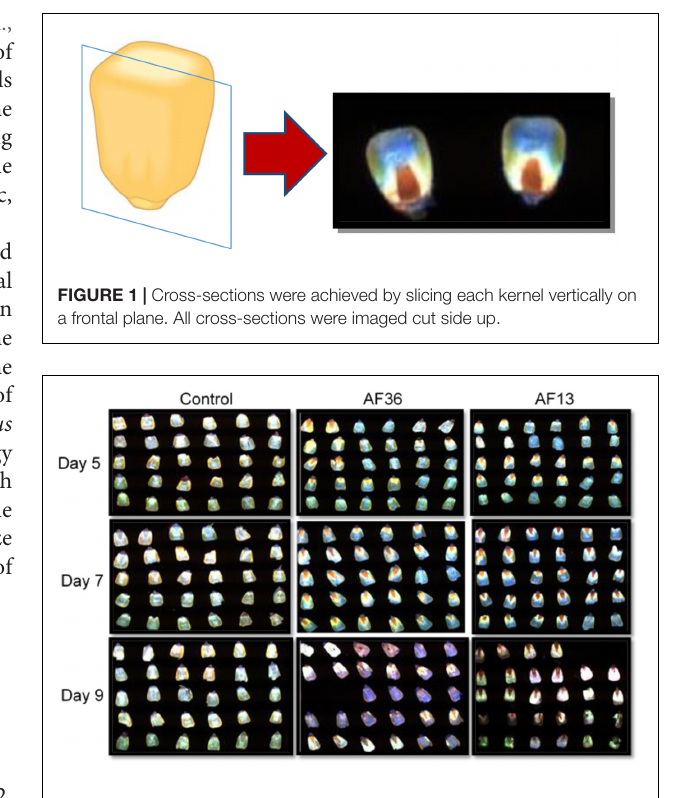
points (5, 7, and 9 days) post-inoculation. A subset of the